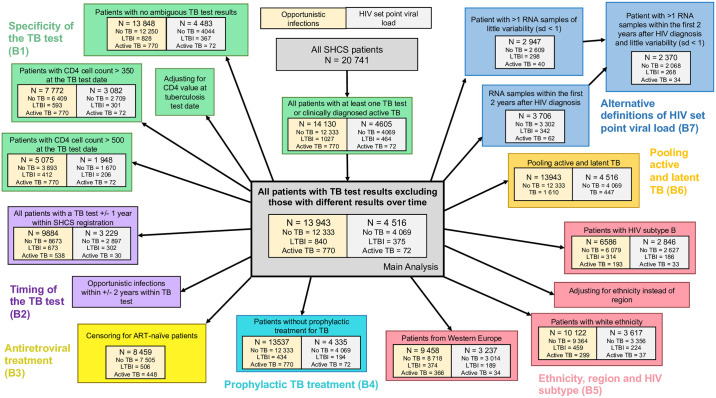
Description of the study population and the sensitivity analyses; B1 to B7 refer to the respective sections in S2 Text.ART, antiretroviral therapy; LTBI, latent tuberculosis infection; SHCS, Swiss HIV Cohort Study; TB, tuberculosis.